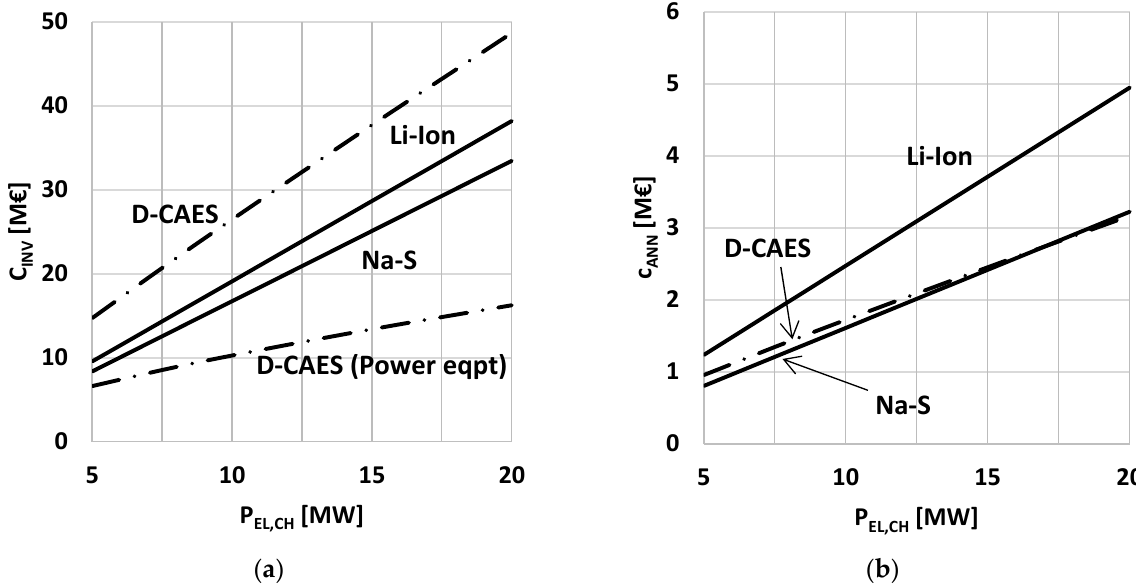
Figure 2. Investment expenditure by varying the rated charging power for storage systems under comparison. Case t CH = t DS = 6 h: ( a ) Investment cost ; ( b ) Annualized capital cost.